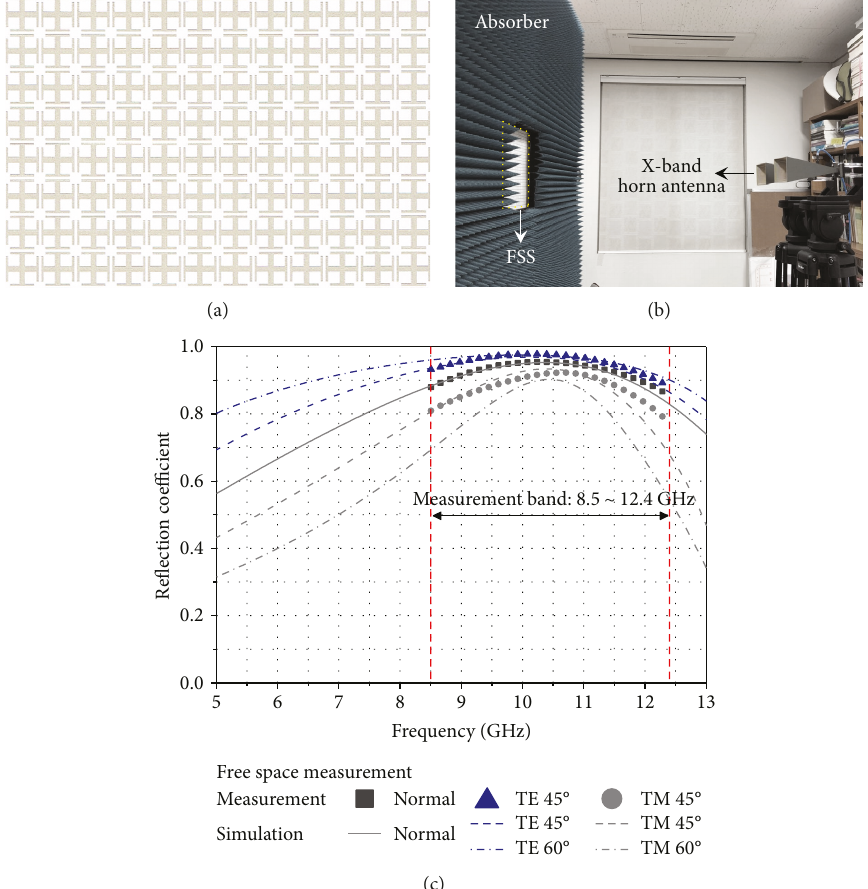
Figure 2: Fabricated security paper and measurement results: (a) fabricated security paper; (b) free space measurement setup; (c) re fl ection